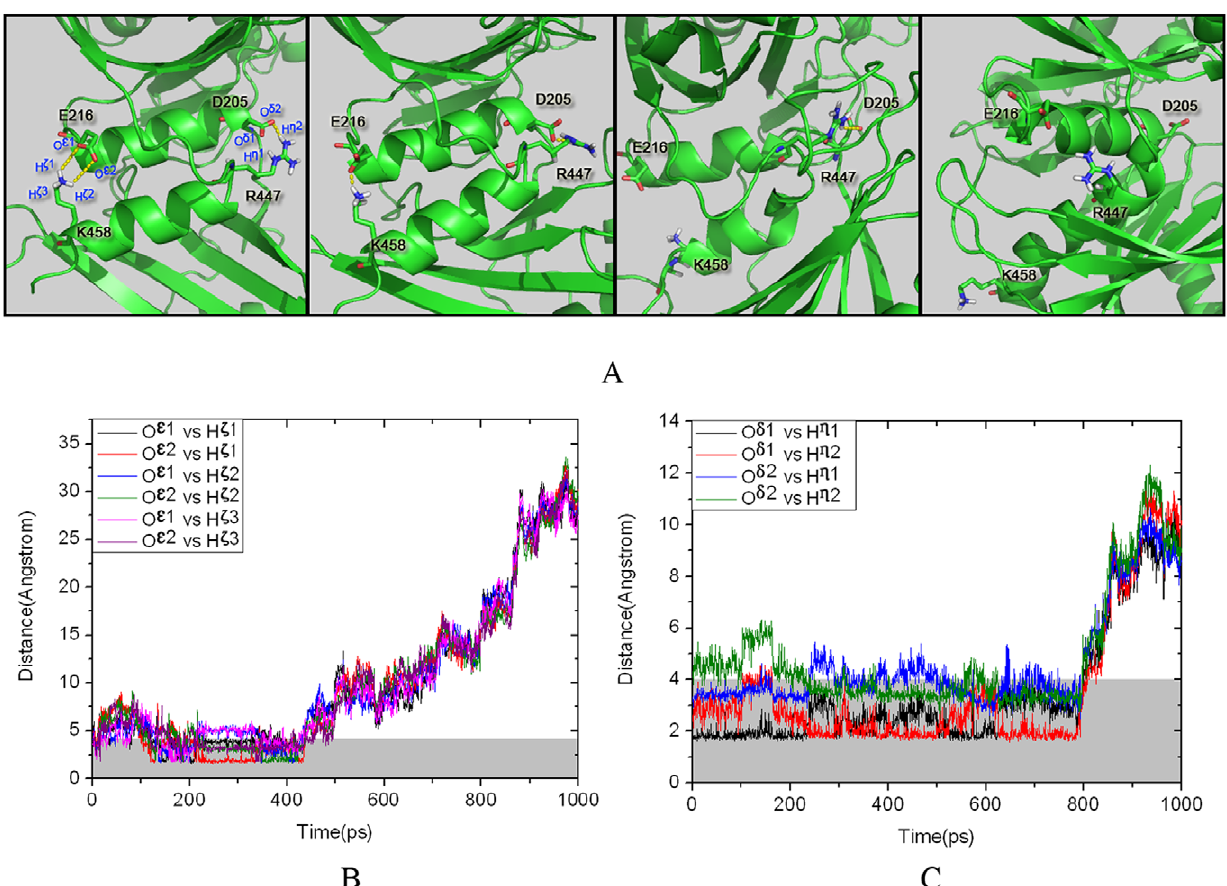
Figure 6. Changes in the hydrogen bonds between residues Asp205 and Arg447 and residues Glu216 and Lys458 during the TMD simulation. (A) Snapshots at 1 ps, 300 ps, 700 ps and 1000 ps. (B) Distances from the O e 1 and O e 2 atoms in Glu216 to the H f 1 , H f 2 and H f 3 atoms in Lys458. (C) Distances from the O d 1 and O d 2 atoms in Asp205 to the H g 1 and H g 2 atoms in Arg447.